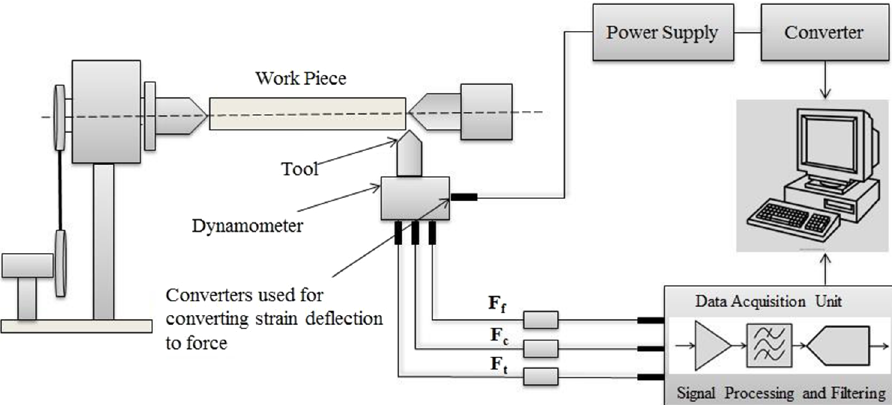
Fig. 1. A symbolic representation of experimental setup depicting workpiece being machined by cutting tool. Data acquisition is done after dynamometer senses force and fed to local server/host for analysis.